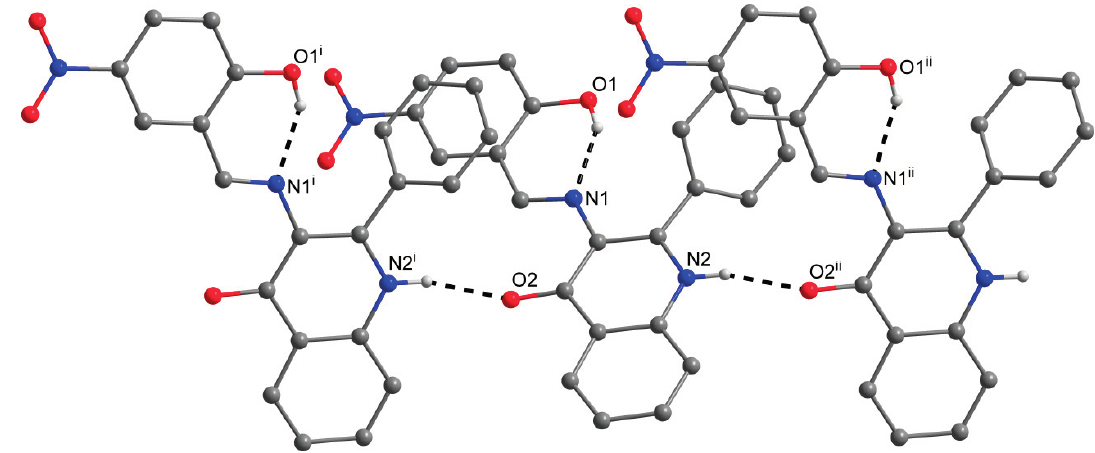
Figure 4. A part of the crystal structure of ( 7 ) showing the O − H···N and N − H···O hydrogen bonds (black dashed lines). The H–atoms not involved in the interactions are omitted for clarity. Symmetry codes: (i) 0.25 + x, 0.25 – y, 0.25 + z; (ii) –0.25 + x, 0.25 – y, –0.25 +